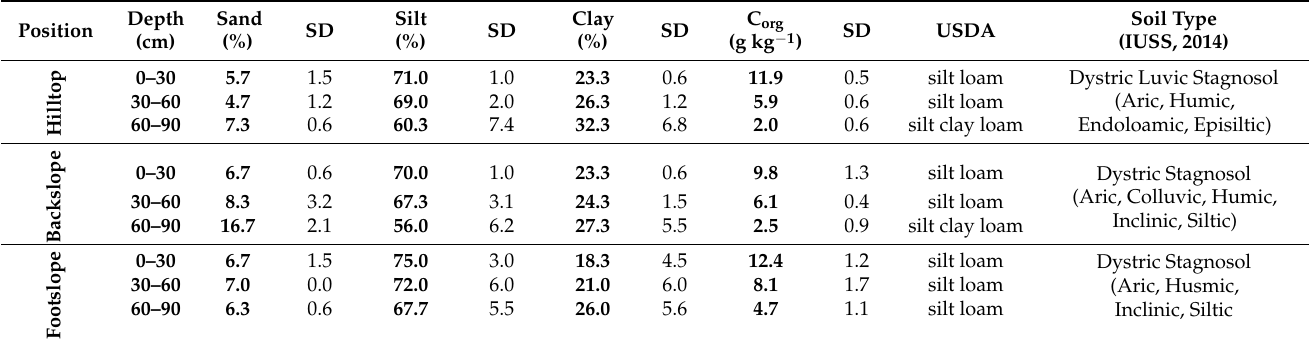
Table 1. Average soil texture and organic carbon content (C org ) at the hilltop, backslope, and footslope for three depths (0–30, 30–60, and 60–90 cm) with standard deviation (SD), and soil type at the SUPREHILL